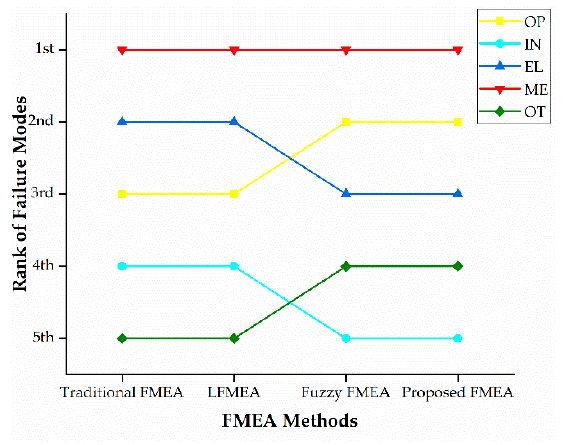
Figure 10. Comparison of FMEA methods for the considered rank of FMs.